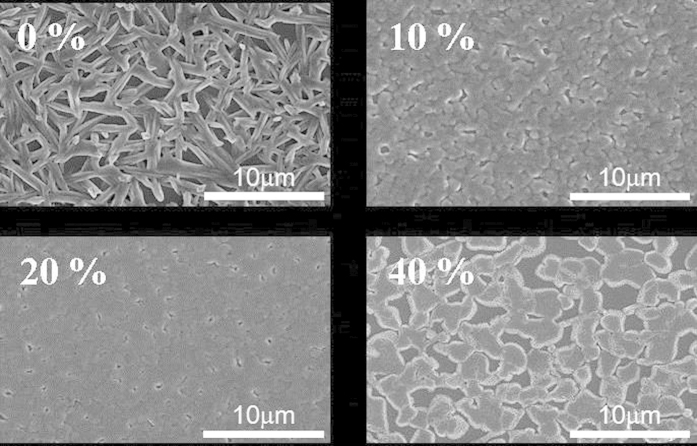
SEM images of the CH3NH3PbI3−xClx films prepared with 0, 10, 20 and 40% of chloride, respectively.